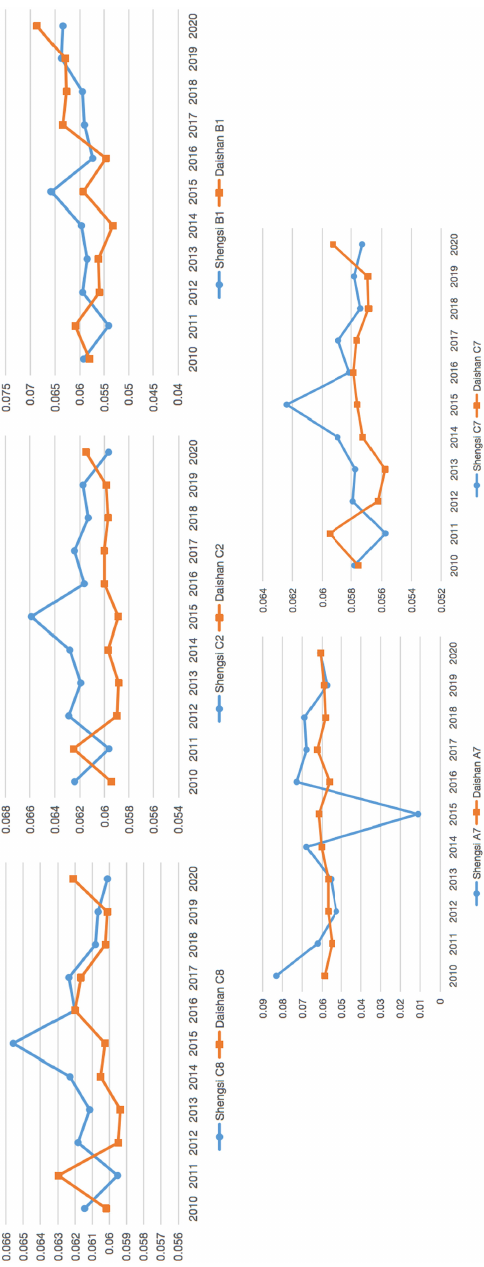
Figure 7. Changes in the degree of obstacles of major influencing